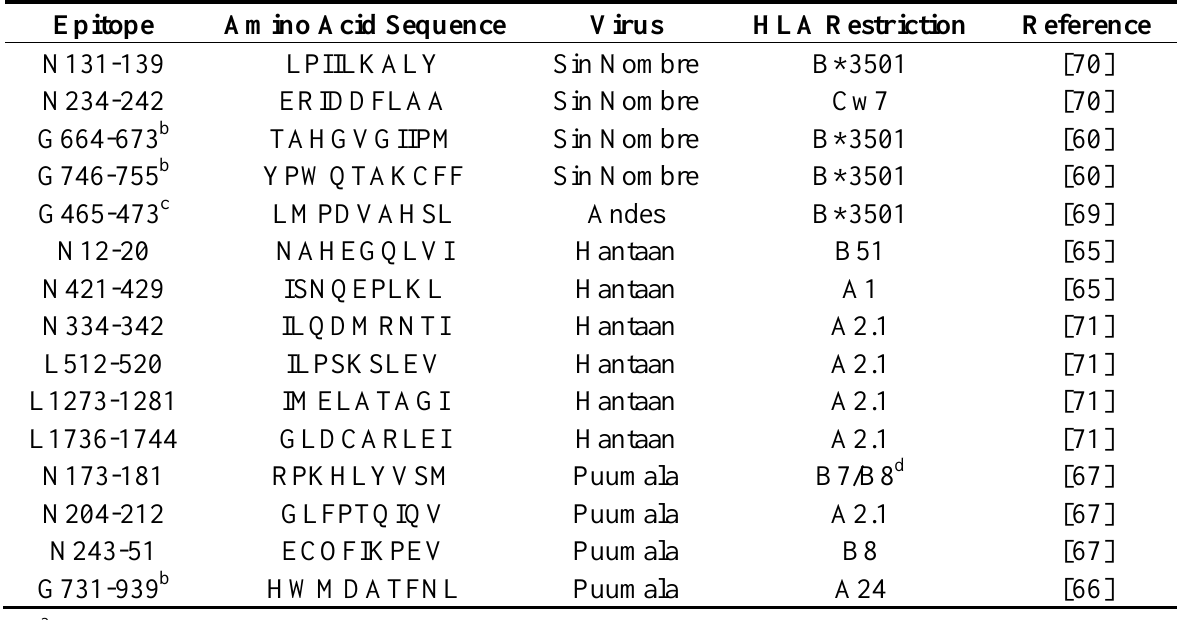
Table 1. CD8 + T cell epitopes identified in hantavirus proteins a